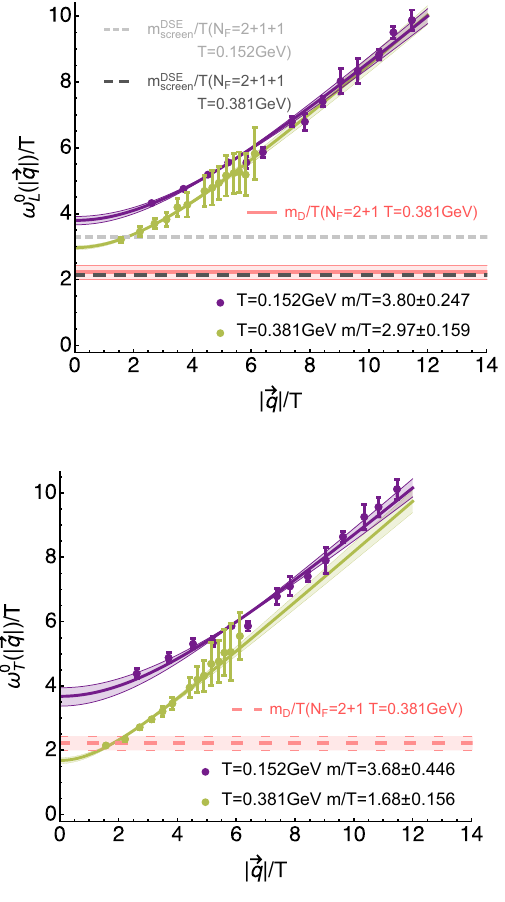
(cid:24) ( | q | ) = A Fig. 12 Momentum dependence of the longitudinal (top row) and B 2 + | q | 2 . The mass of the quasi-particle excita- ansatz ω 0 L transversal (bottom row) quasi-particle peak position at β = 2 . 10. In tion is defined as the value of the intercept m = AB . As comparison to the left column we show ω 0 results in the literature we include here on the one hand the Debye mass for those eight temperatures at which L / T evaluated from the heavy-quark potential in N f = 2 + 1 lattice QCD the default-model dependence was mild enough for a robust determi- nation and we find that all of them take on a non-zero value for small as red solid line. On the other hand we show for the longitudinal sector spatial momenta. In both the longitudinal and the transversal sectors previous estimates of the electric screening mass obtained from Dyson– the reconstructions at the two lowest temperatures within the hadronic Schwinger computations including N f = 2 + 1 + 1 quark flavors as phaseseemtoexhibitalargerinterceptthanthecurvesinthedeconfined gray dashed phase. (Right) Fit of the lowest and highest temperature curves with the